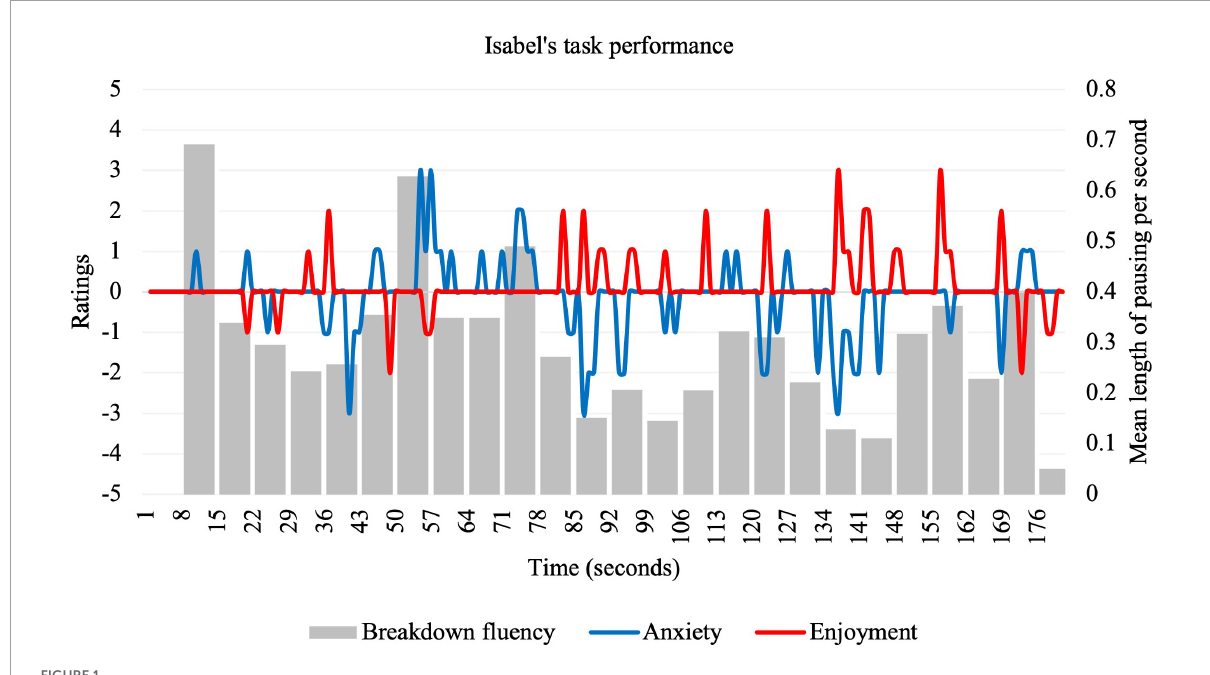
FIGURE1 Idiodynamic ratings and breakdown fluency per segment for Isabel’s task performance.